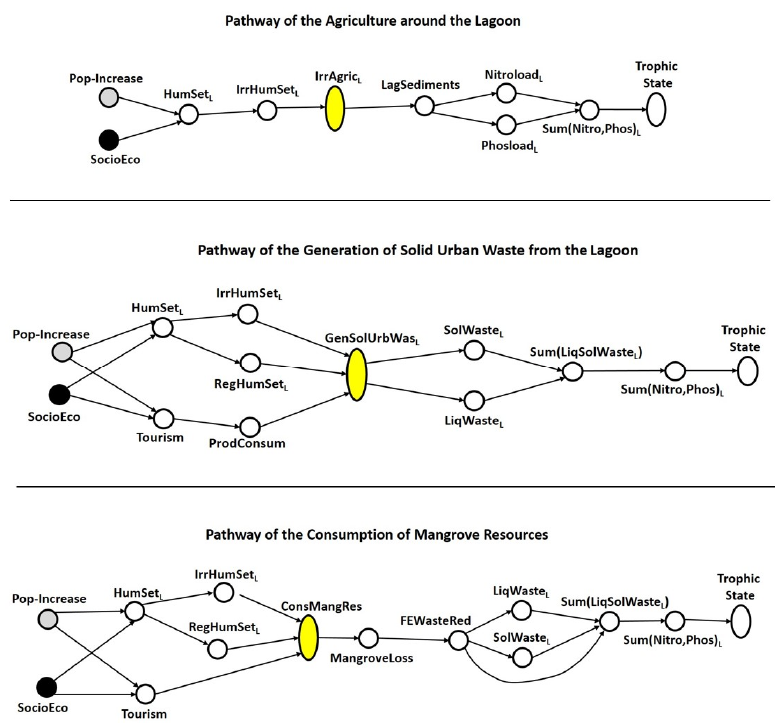
Figure 3. The pathways related to the lagoon.